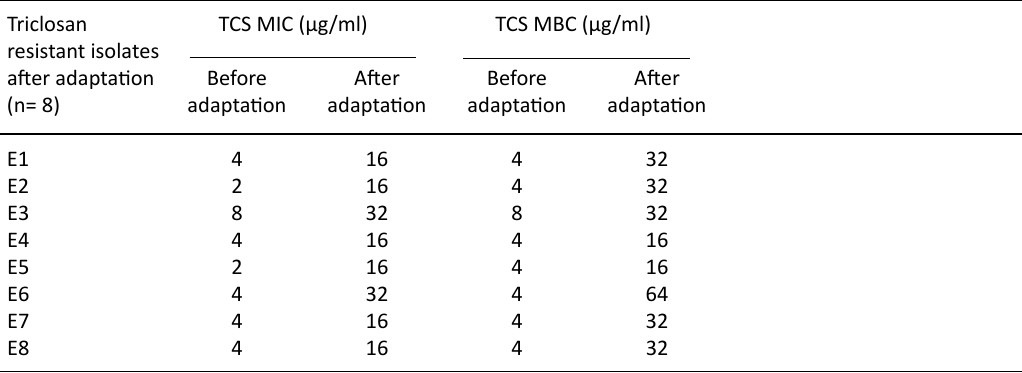
Table 3. Minimum inhibitory TCS concentration (MIC) and minimum bactericidal concentration (MBC) of tolerant E. coli isolates after adaptation (N=8) Triclosan TCS MIC (μg/ml) TCS MBC (μg/ml) resistant